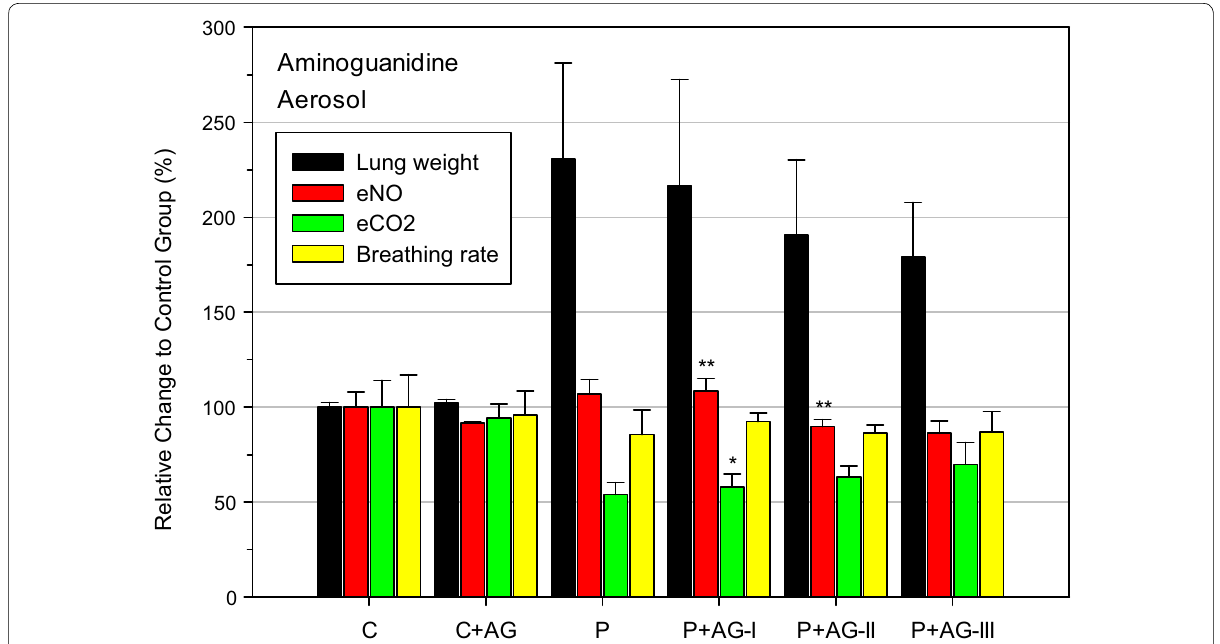
Fig. 7 Impact of the inhaled NOS-inhibitor AG-aerosol on the phosgene-induced changes in lung weights, eNO, eCO 2 , and breathing frequency. AG (dissolved 7% in deionized water) was aerosolized to be inhalable for rats [44]. Control rats were nose-only exposed for 30 min to dry air (C). Rats from all other groups were similarly exposed for 30 min to phosgene ( 900 mg/m 3 min). AG groups were exposed to AG-aerosols in three ≈ × modifications: (I) 300 mg drug/m 3 for 30-min (nose-only, b.i.d. 0.5 and 5 h post-exposure to phosgene). (II) Same treatment regimen as (I) but animals were exposed unrestrained in small whole-body exposure chambers. (III) Same treatment regimen as (II) but the same inhalation dose was continually delivered over 6 h at 50 mg drug/m 3 . Hence, all groups received the same Cxt of drug. All endpoints were determined approximately 20 h post-exposure to phosgene. Bars represent means SD (n 5). Asterisks denote significant differences of AG-groups relative to the phosgene ± = (P) group (*P < 0.05, **P <